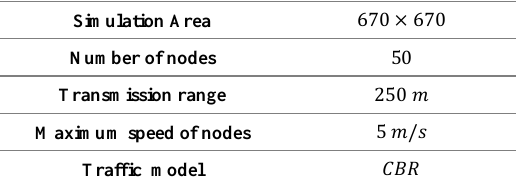
Table 1. Simulation parameters.